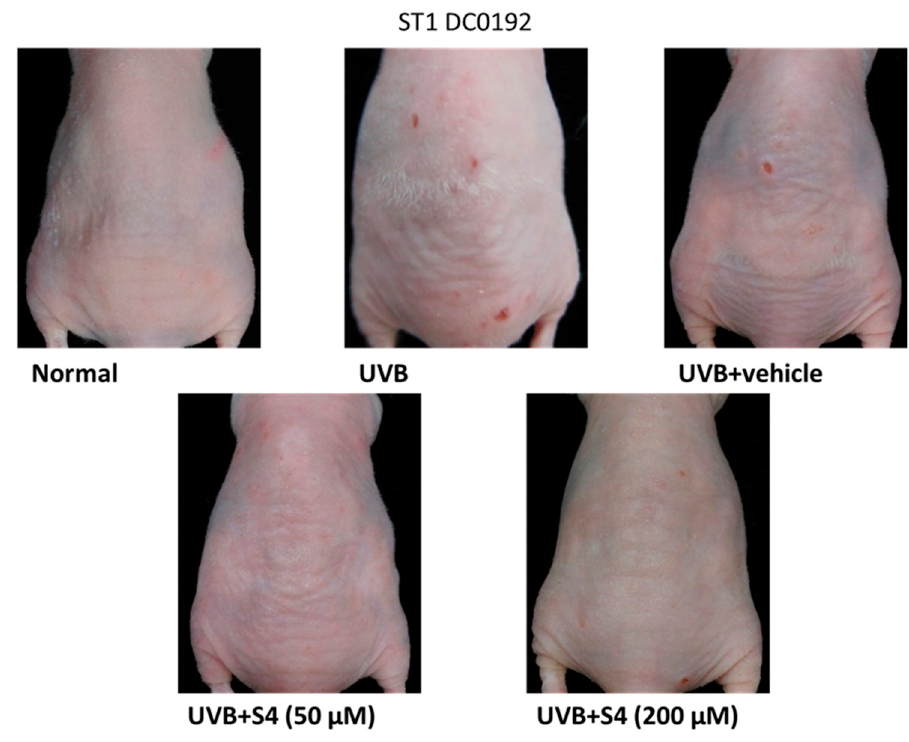
Figure 11. Photographs show skin wrinkles induced by chronic UVB irradiation and the effect of topically applied S4.